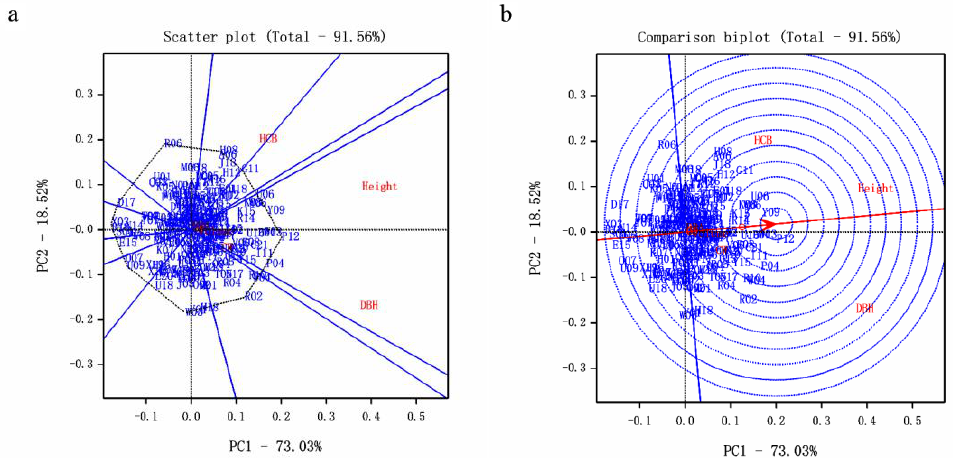
Figure 6. Biplot analysis based on all traits of 199 families. ( a ) Polygon view of GGE Biplot—which is best for what, ( b ) Genotypes of ranking families. DBH, diameter at breast height; HCB, height to live crown base; CW, crown width; SF, stem form; CS, crown shape; BRA, branchiness; A,